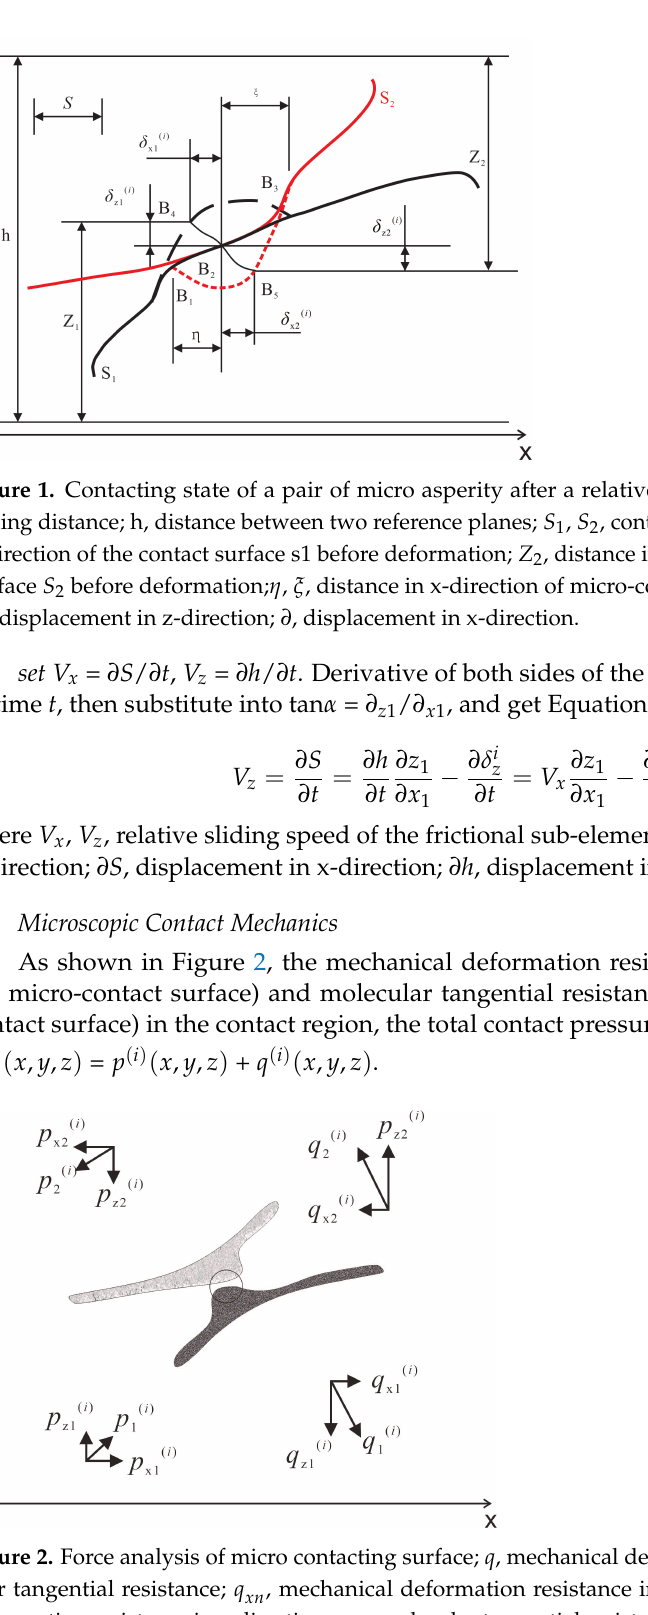
, mechanical zn , molecu- zn